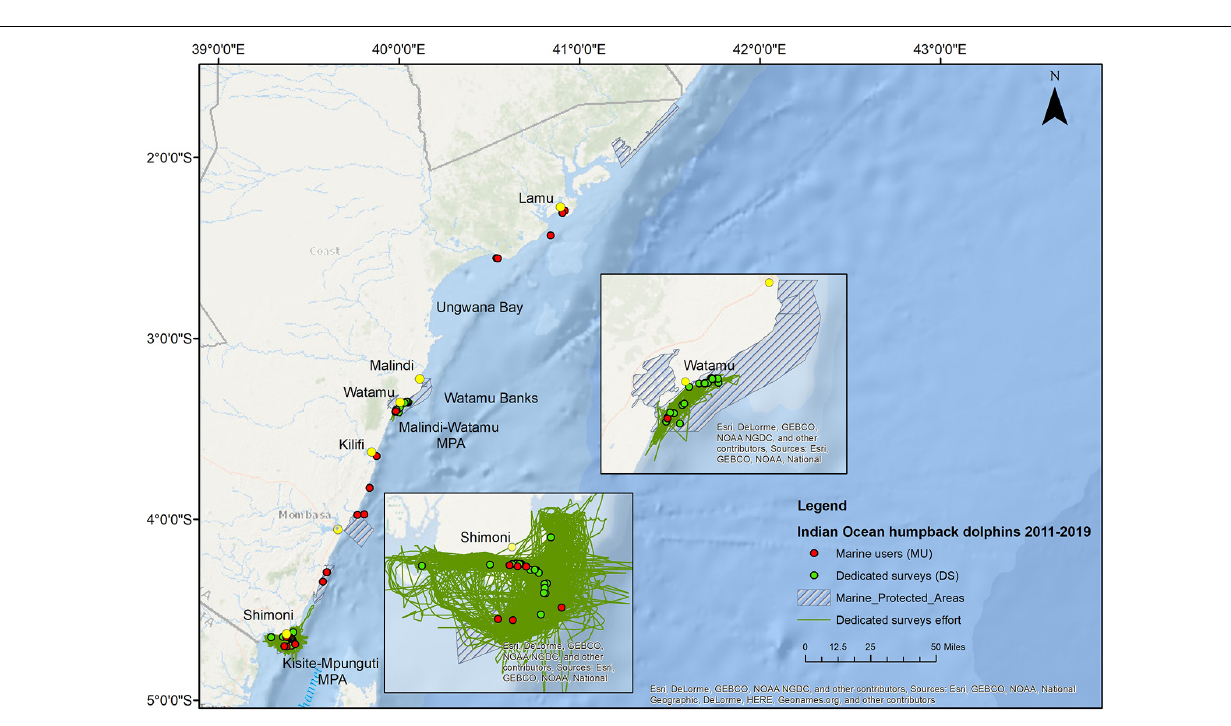
FIGURE 7 | Map showing the distribution of Indian-Ocean humpback dolphin sightings between 2011 and 2019 along the Kenyan coast. The boxes in the map show the areas with the highest number of reports, Kisite-Mpunguti Marine Protected Area (southern Kenya) and Malindi-Watamu Marine Protected Area (central